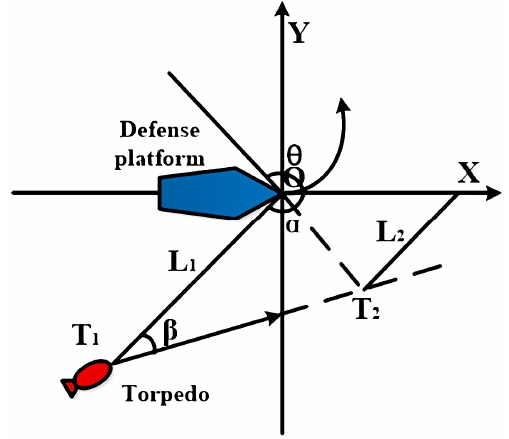
Figure 2. The defense platform avoidance